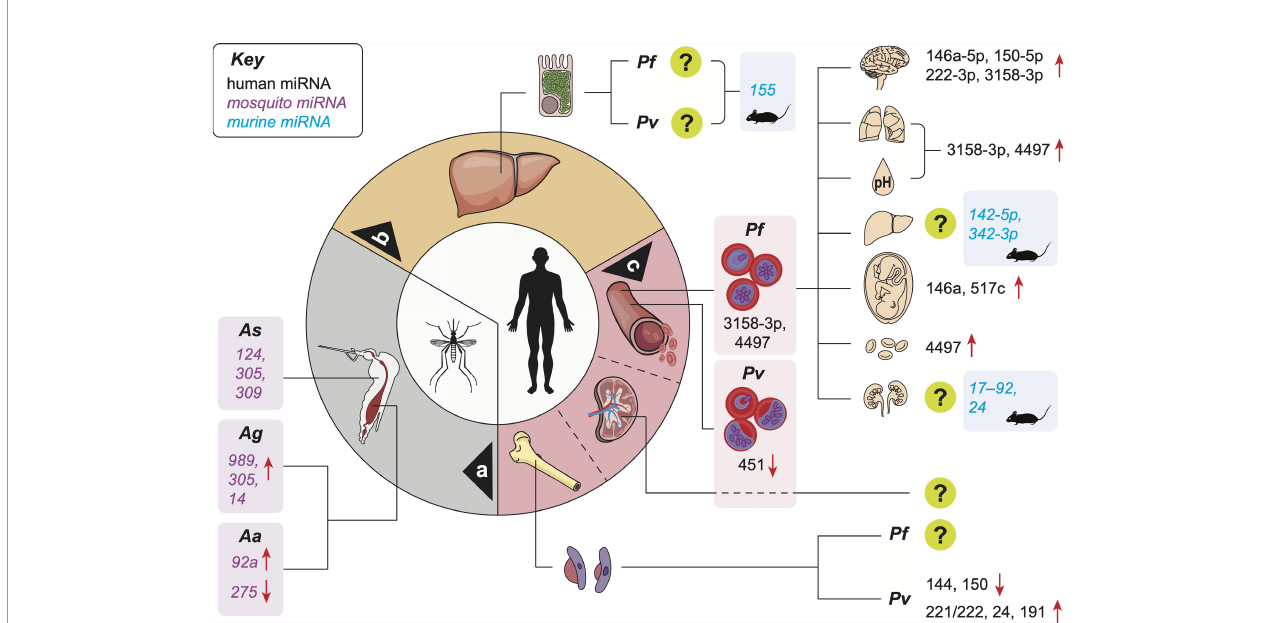
FIGURE 1 | Reported miRNA expression changes in the vector and host during malaria infection. miRNA level changes in the midgut of infected mosquitoes a ; in animal models of the infection during the silent hepatic phase b ; and in patients during the symptomatic erythrocytic phase c . Organ and metabolic dysfunctions represented in the upper right quadrant are, from top to bottom: brain (cerebral malaria), lungs (ARDS), acidosis (hyperlactatemia), liver (jaundice), placenta (PAM), decreased red blood cell count (anemia), kidneys (AKI). [upregulation ( ↑ ); downregulation ( ↓ );?: human miRNAs not identi fi ed; Pf , Plasmodium falciparum ; Pv , Plasmodium vivax ; Aa , Anopheles anthropophagus ; Ag , Anopheles gambiae ; As , Anopheles stephensi